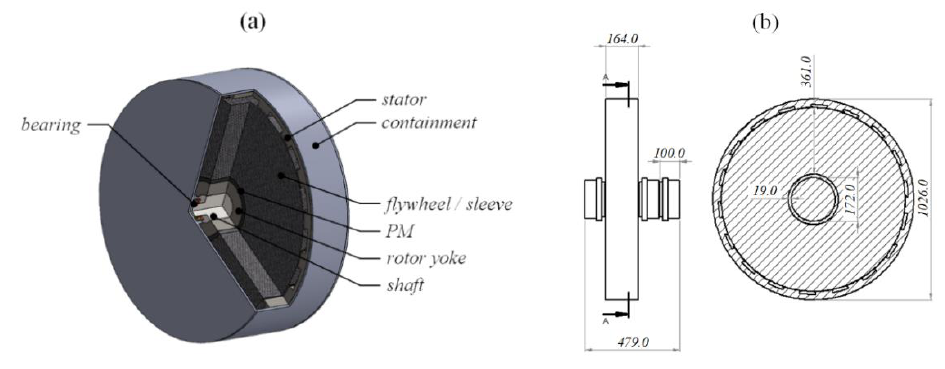
Figure 2. Some views of the IRLA-SPM designed for the proposed FESS: ( a ) 3D and ( b ) 2D (dimen- sions in mm).